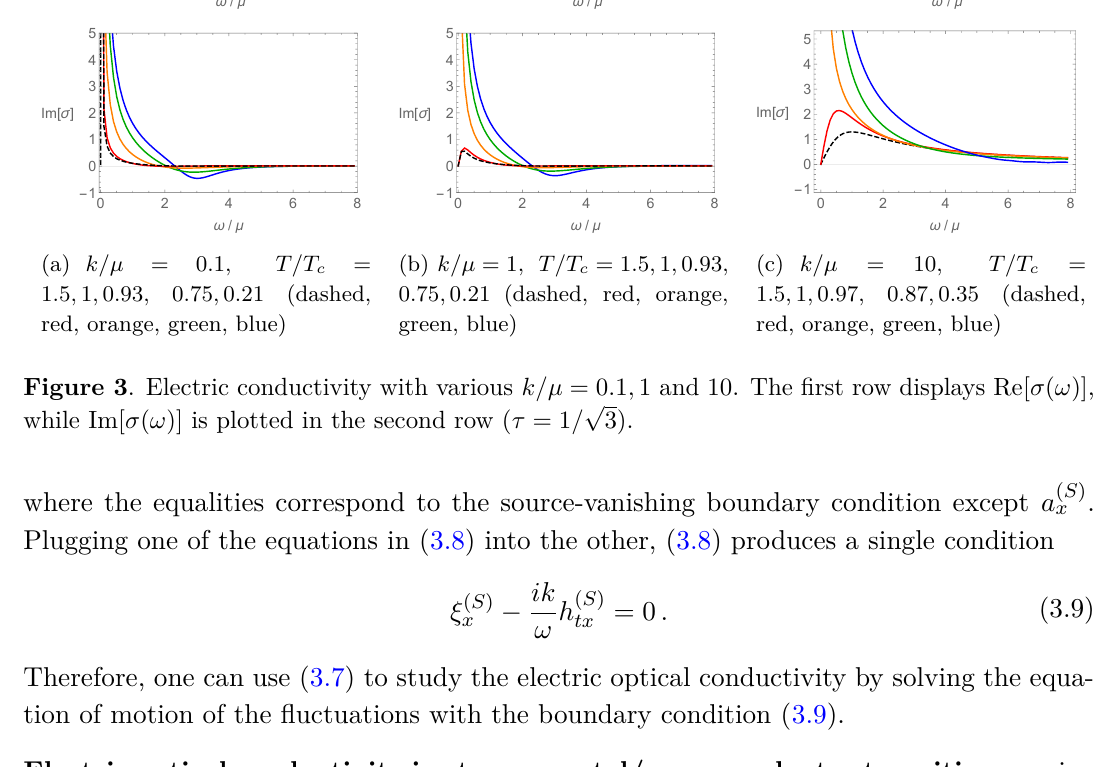
where the equalities correspond to the source-vanishing boundary condition except a ( S ) x